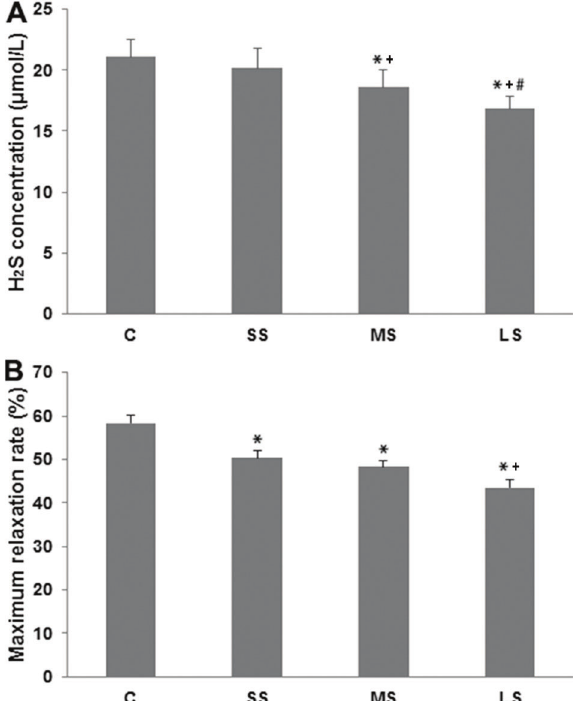
Figure 1. Serum H 2 S concentration ( A ) and maximum relaxation rate to NaHS of thoracic aorta ( B ) in control (C), short-term smoking (SS), middle-term smoking (MS) and long – term smoking (LS) groups. Data are reported as means ± SD. *P o 0.01 compared with C group; + P o 0.01 compared with SS group; # P o 0.05 compared with MS group